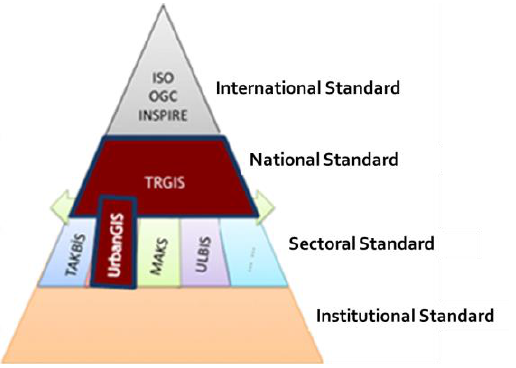
Figure 1. Standardisation pyramid of Turkey (GD-GIS, 2012a) TRKBIS objects have 2D geometry that is defined with GML 3 geometry types. Scale and resolution properties of the standard are defined based on Large Scale Map Information Production Regulation (BOHHBUY in Turkish). In Urban GIS data model, maps that have scale larger than 1:5000 are defined as large scale maps according to the regulation. The use of geo-data is determined with 5 level of detail from district (level4), county (level3), province (level2), region (level1), to country (level0). County level (Level3-Large Scale) is the most effective level for GIS applications in Turkey. Therefore it is accepted as base geo-database level (Aydinoglu 2009). TRKBIS is related with county level and involves geo-data larger than 1:5000 scale. Municipalities and provincial administrations produce and update geo-data from county level to district level (Figure 2).